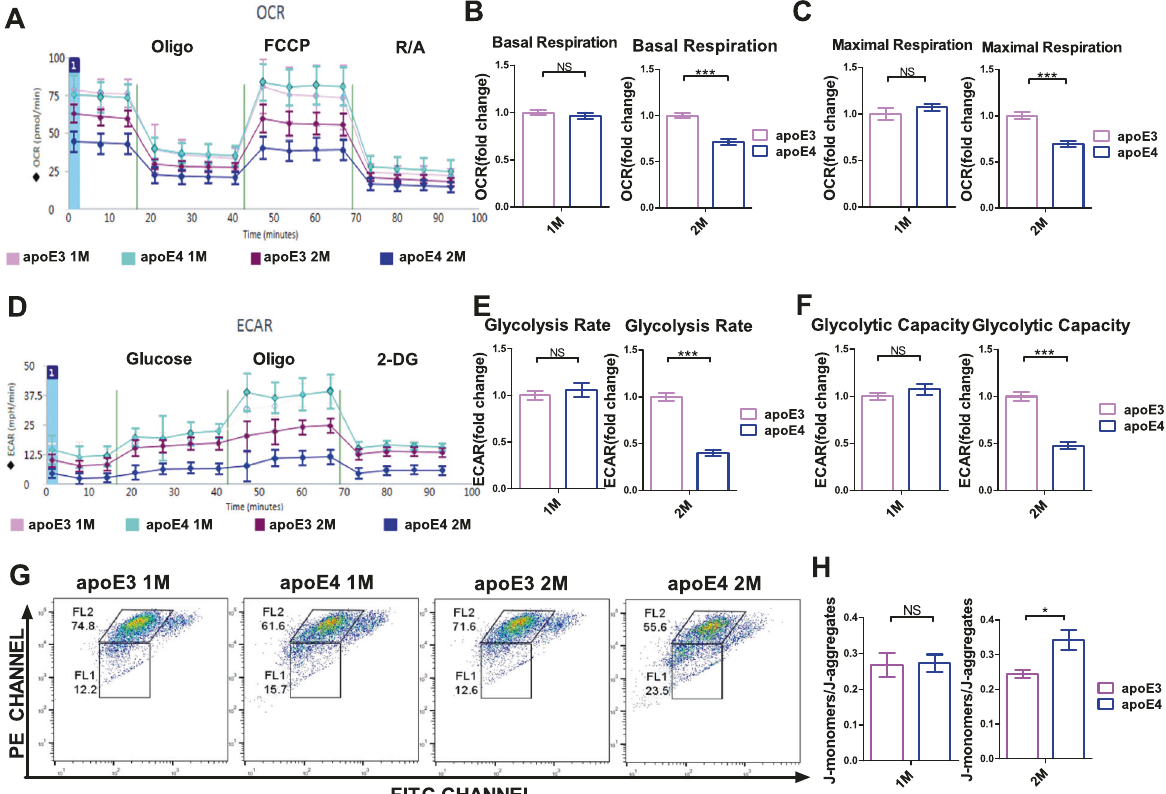
Fig. 4 The disrupted glucose metabolism in primary astrocytes by APOE ε 4 allele in a culture-time-dependent manner. A Bioenergy curves of changes in the rate of oxygen consumption (OCR) over time after the injection of various compounds that inhibited key enzymes in the mitochondrial electron transport chain. B The basal respiration of primary astrocytes from apoE3-TR and apoE4-TR mice after 1 and 2 months of culture. *** p < 0.001, by two-tailed Student ’ s t tests ( N = 12 – 16). C The maximal respiration of primary astrocytes from apoE3-TR and apoE4-TR mice after 1 and 2 months of culture. *** p < 0.001, by two-tailed Student ’ s t tests ( N = 12 – 16). D The change curve of extracellular acidi fi cation rate (ECAR) indirectly produced by glucose conversion to lactic acid during glycolysis. E The glycolysis rate of primary astrocytes from apoE3-TR and apoE4-TR mice after 1 and 2 months of culture. *** p < 0.001, by two-tailed Student ’ s t tests ( N = 12 – 16). F The glycolytic capacity of primary astrocytes from apoE3-TR and apoE4-TR mice after 1 and 2 months of culture. *** p < 0.001, by